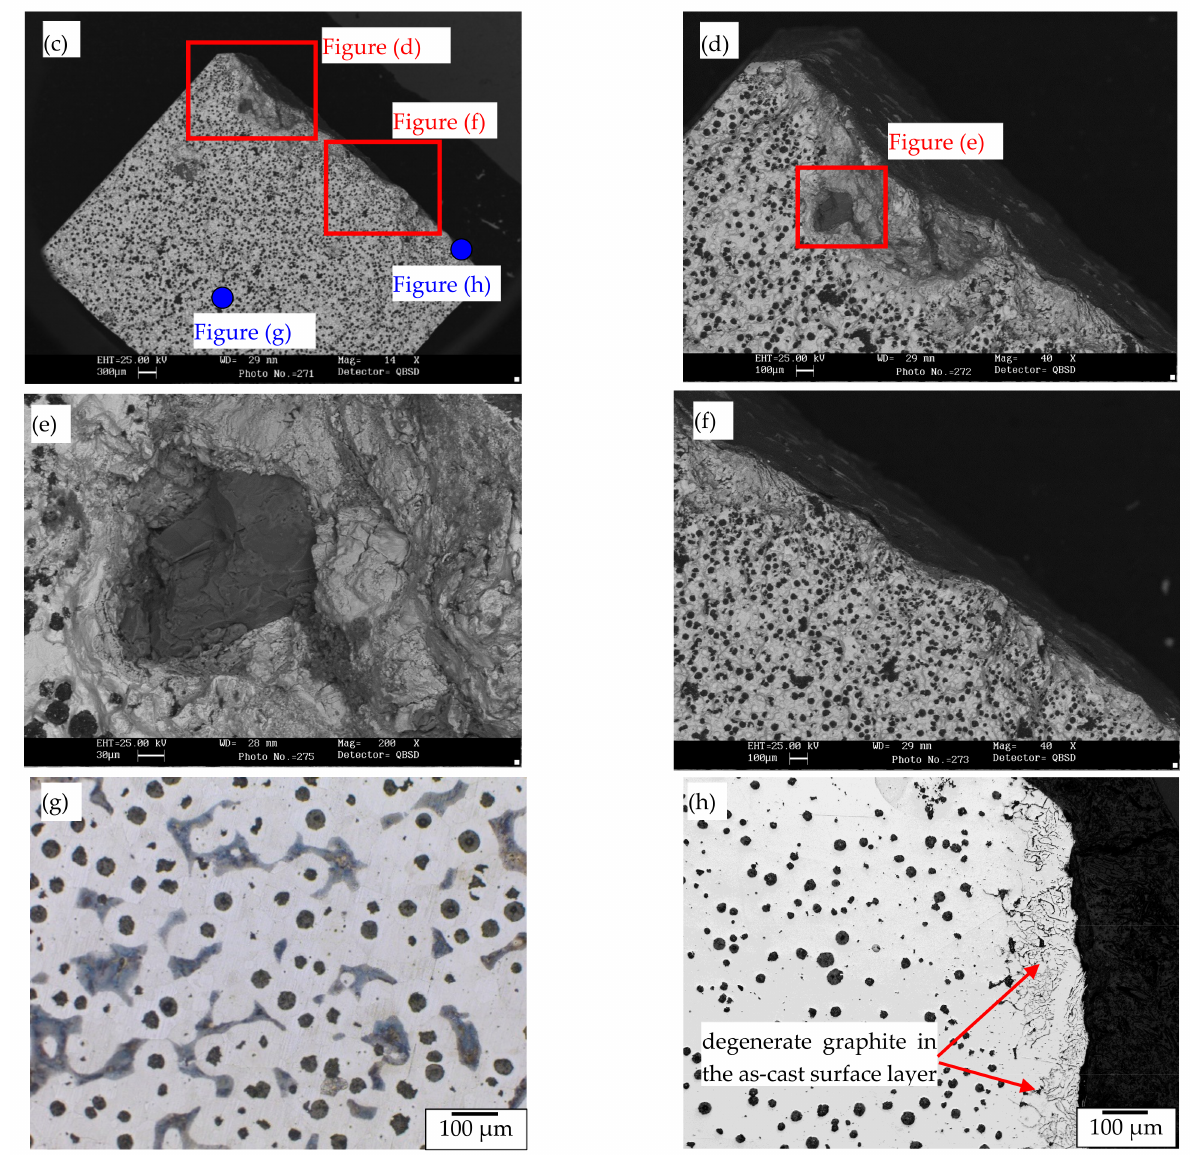
Figure 15. Fracture surfaces of a plain specimen (Figure 6) made of EN-GJS-450-10 and tested at ε a = 3000 µε under R ε = − 1 in the as-cast conditions. Failure occurred at 2N f = 898. Fracture surfaces observed with ( a , b ) a digital microscope and ( c – f ) a SEM microscope. Microstructure observed by optical microscope at ( g ) the center of the sample and ( h ) the as-cast surface.